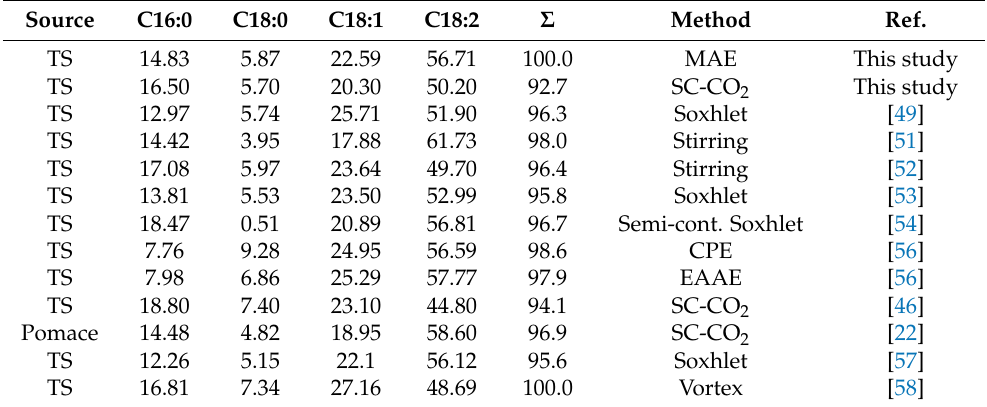
Table 6. Comparison of fatty acid composition (wt%) of TSO obtained in this work and the reported results in